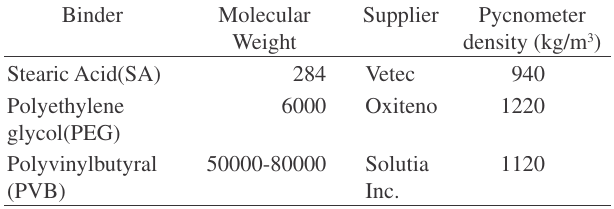
Table 1. Characteristcs of binders used in this study.